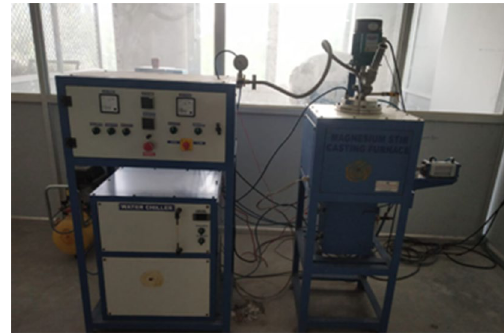
Fig.3 Stir casting machine for fabrication of composite